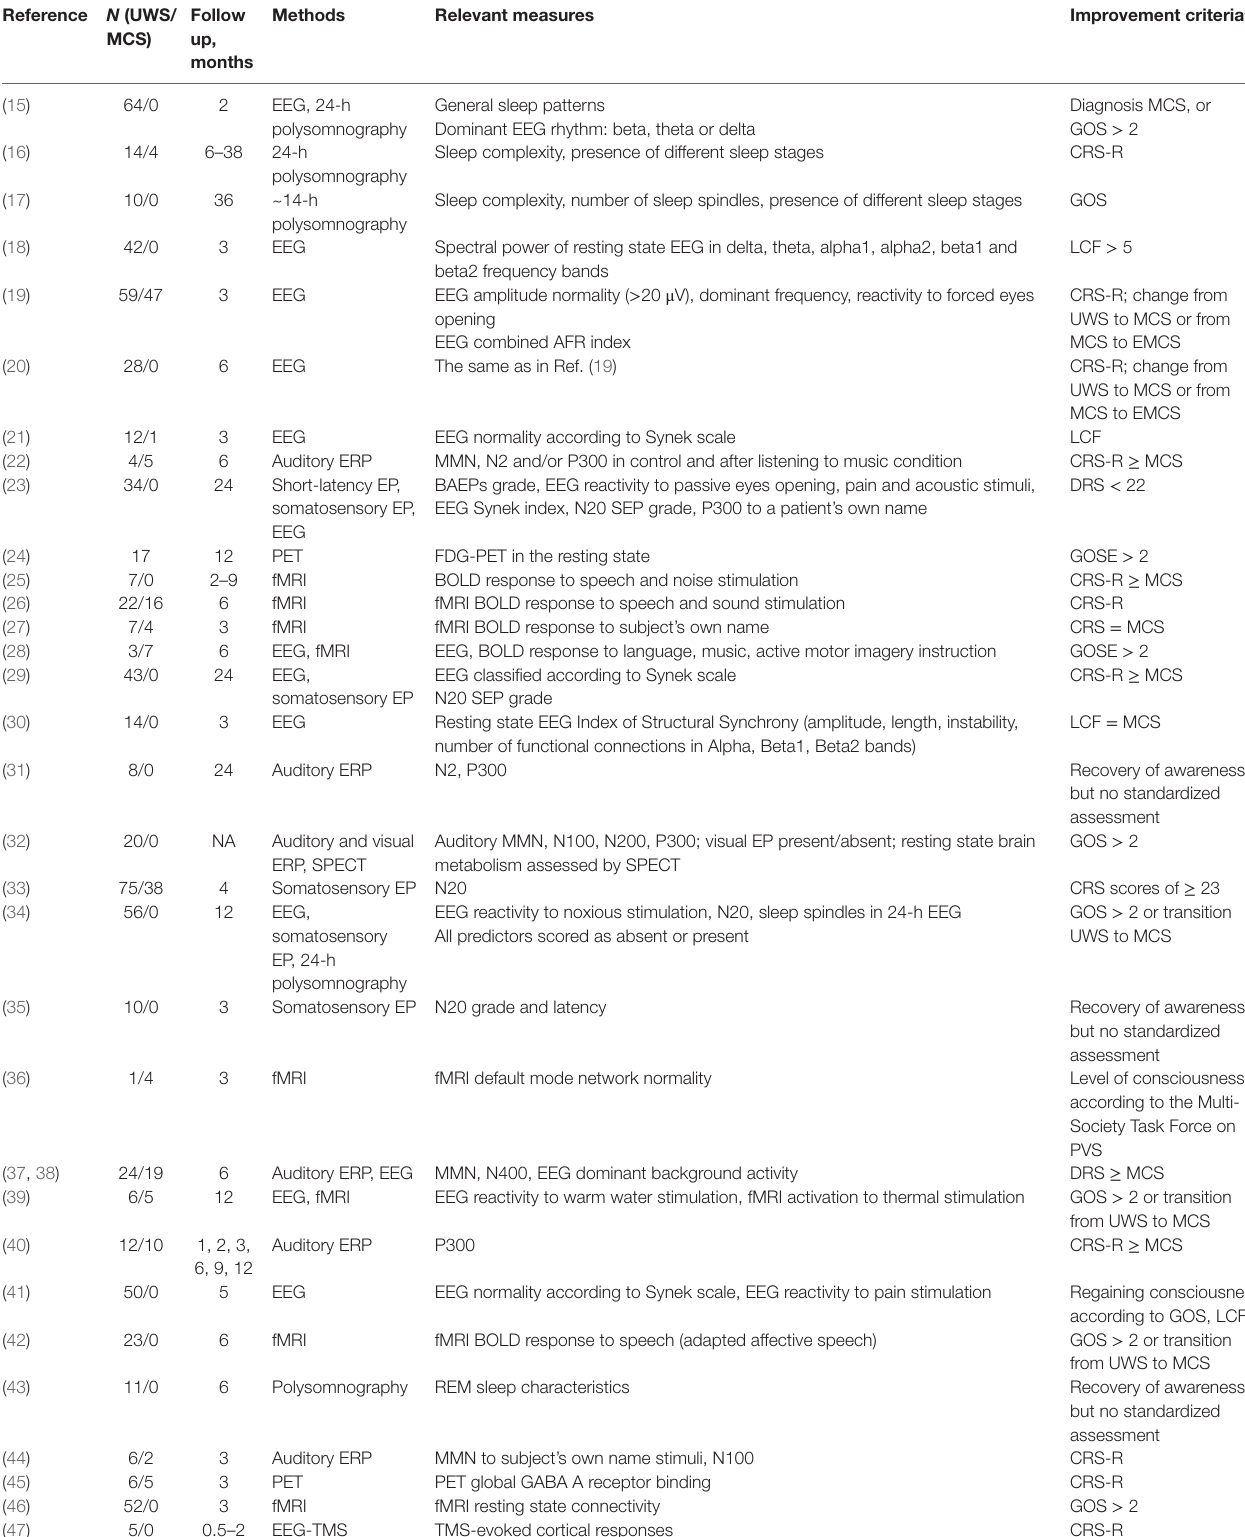
taBLe 1 | A summary of the 47 records included in the systematic review. Reference N (uwS/